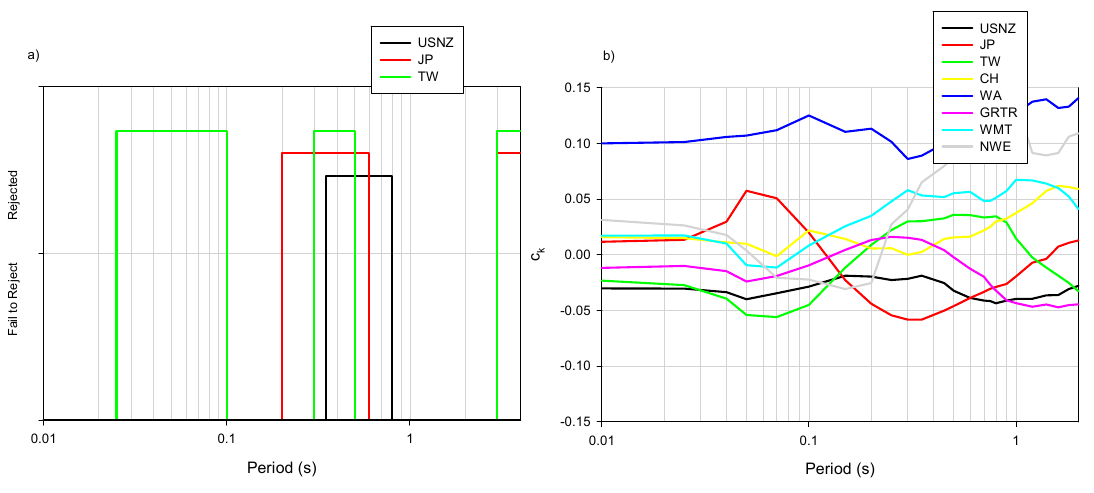
Figure 8. ( a ) The significance test results for USNZ, JP and TW, ( b ) the c k for each region.